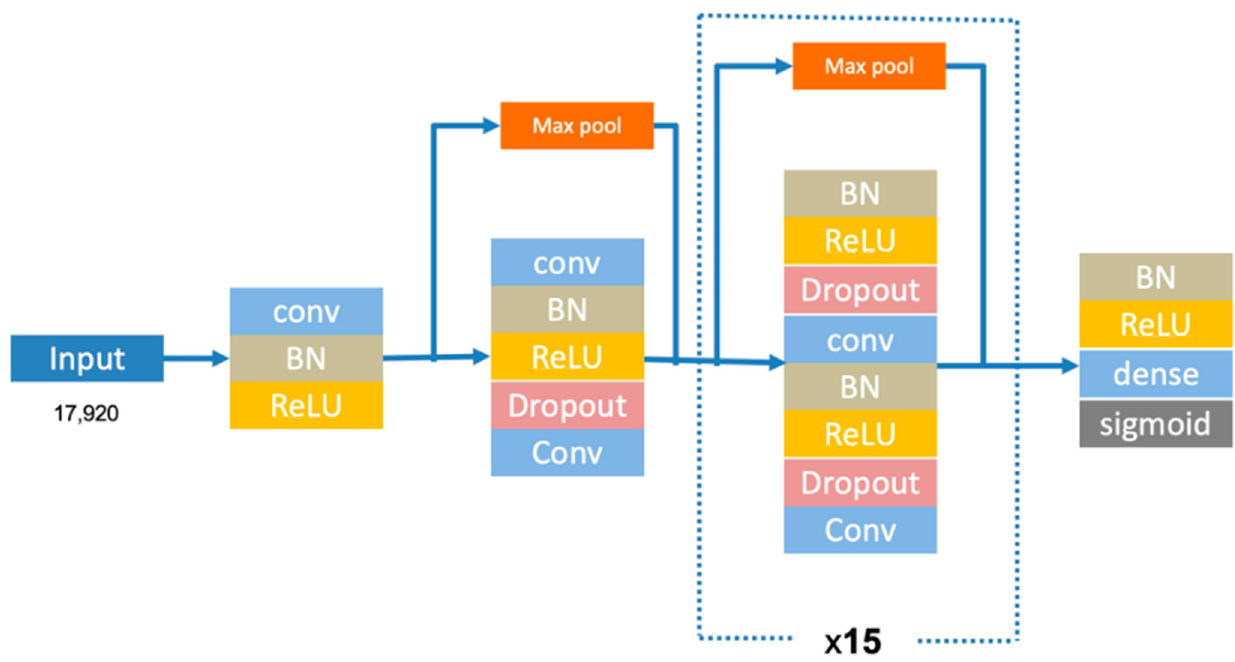
Figure 13. Deep learning model architecture.